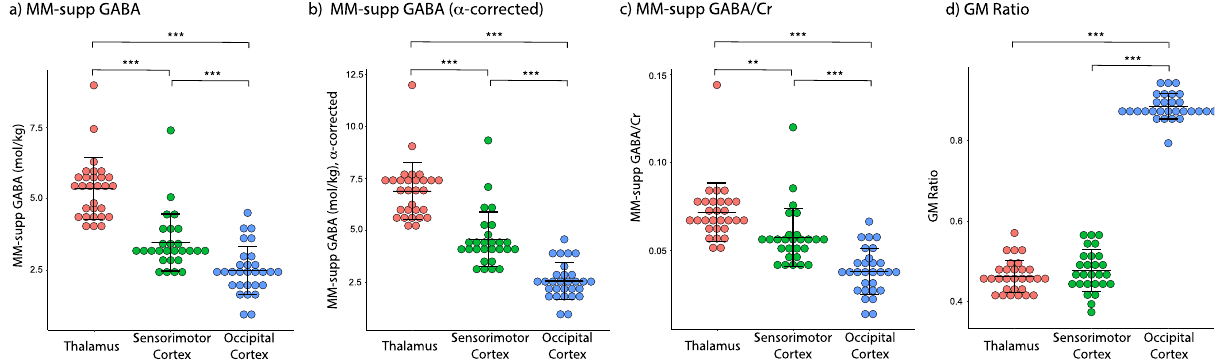
Figure 2. Regional differences in MM-Supp GABA levels and GM ratio. ( a ) MM-supp GABA. ( b ) MM-supp GABA (α-corrected). ( c ) MM-supp GABA/Cr. ( d ) GM ratio. Lines represent mean ± standard deviation. **p < 0.01, ***p <